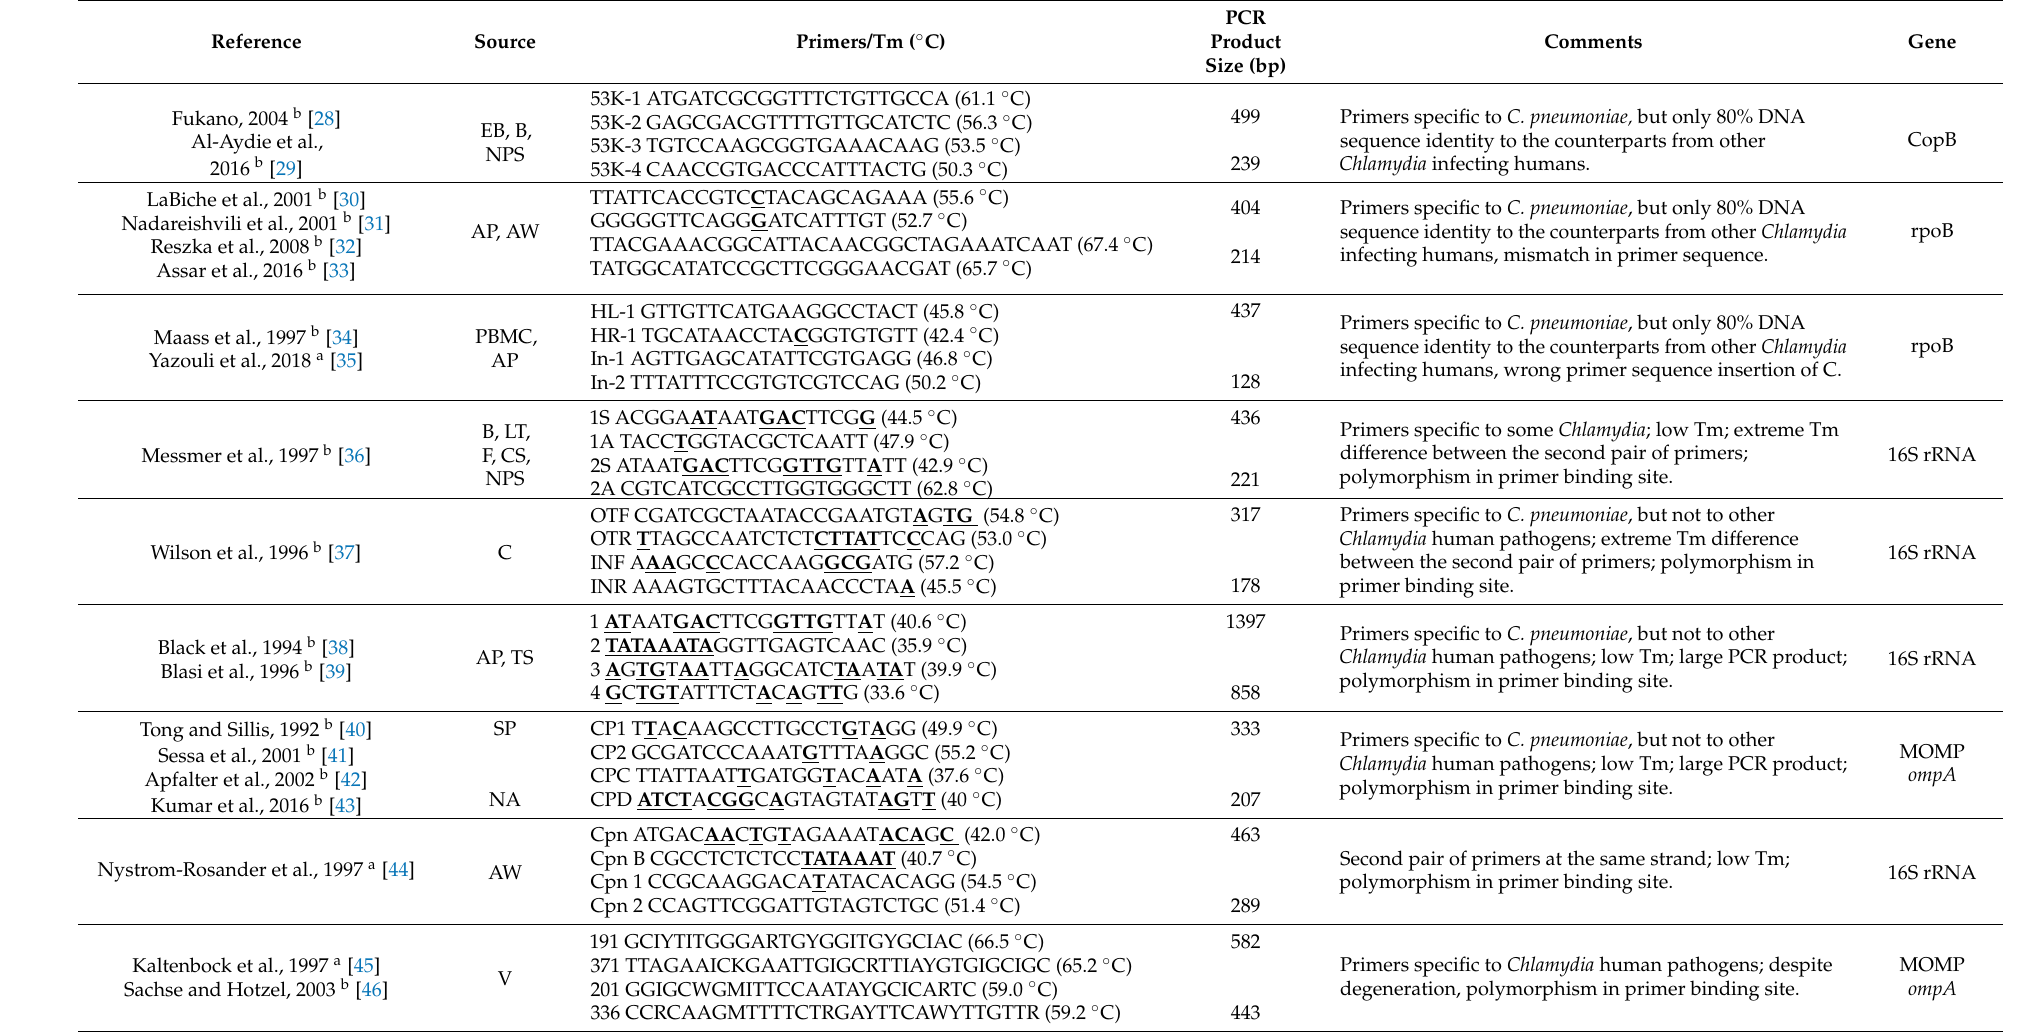
Table 3. Pros and cons of NPCR assays used for the identification of C. pneumoniae